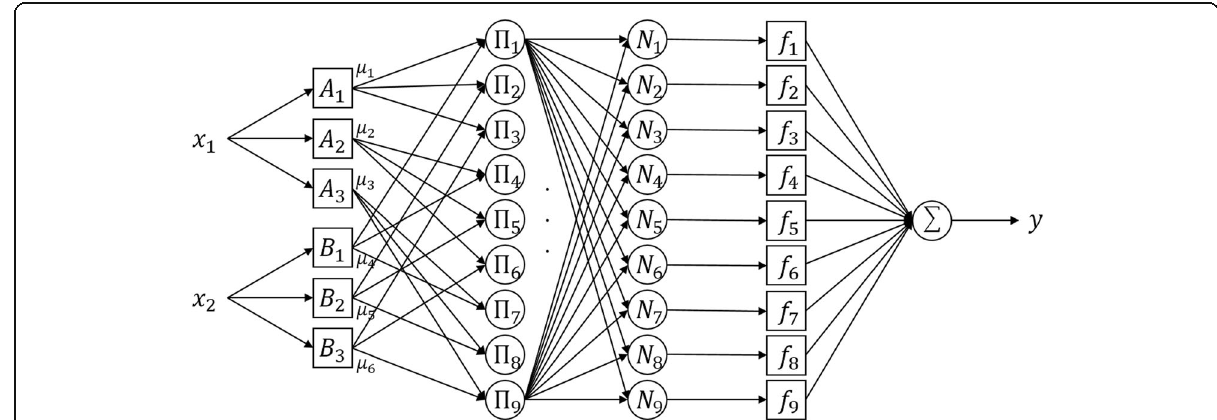
Fig. 2 The ANFIS structure of the proposed ABR